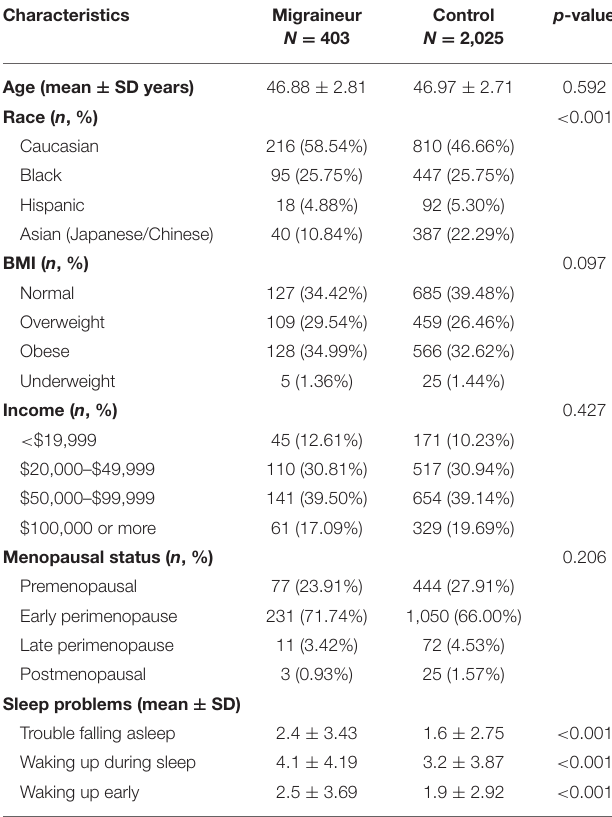
TABLE 1 | Baseline